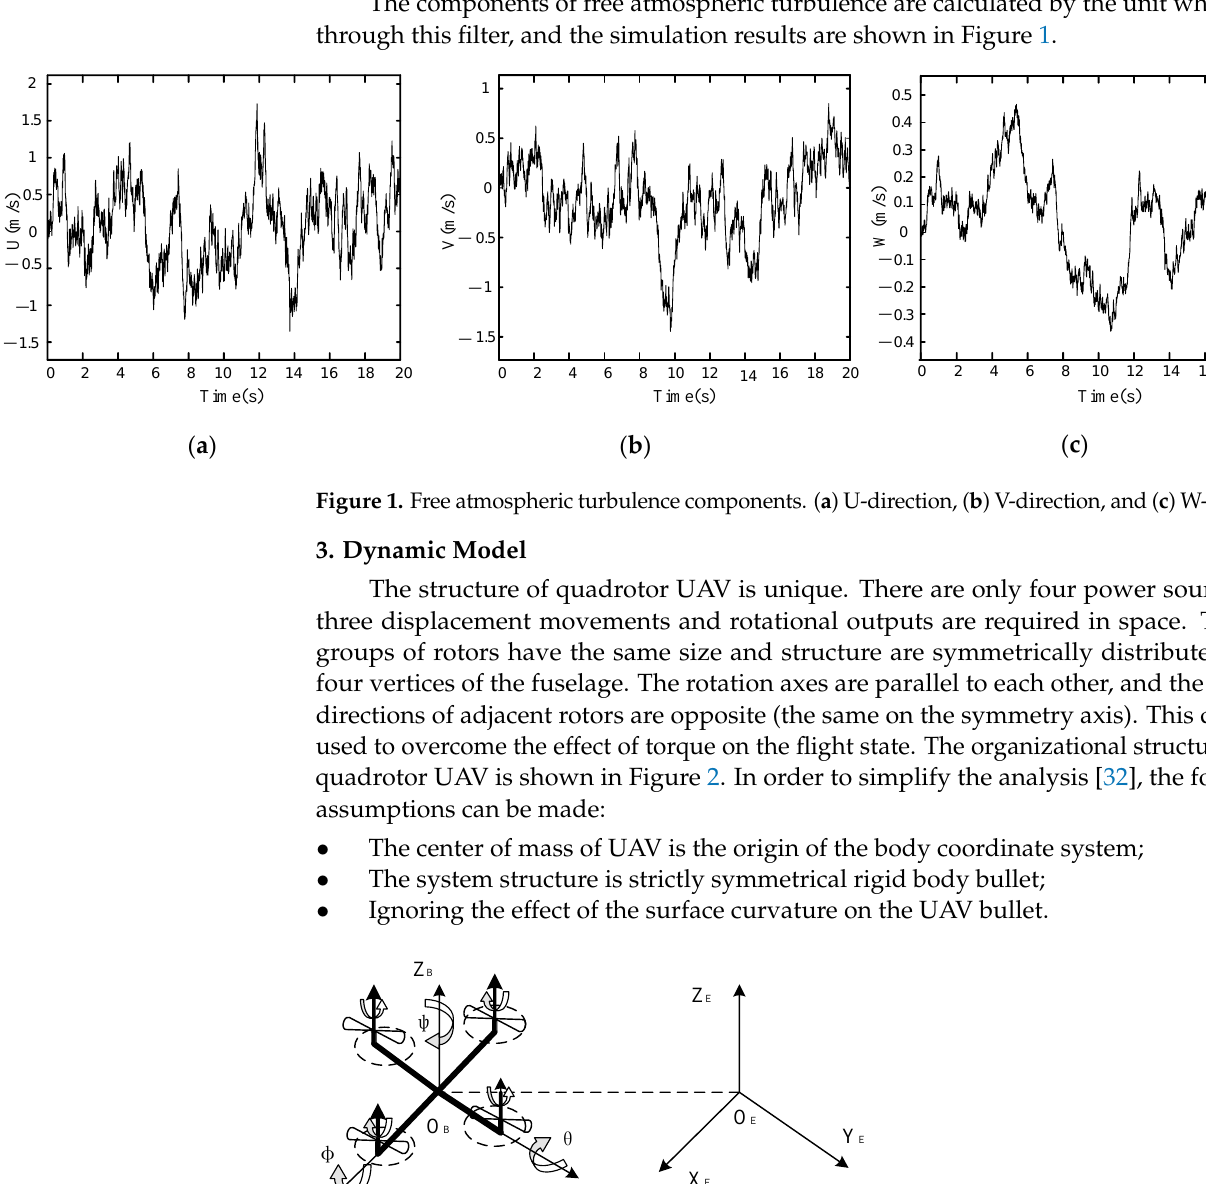
Table 1. Atmospheric turbulence scale and intensity parameter values.